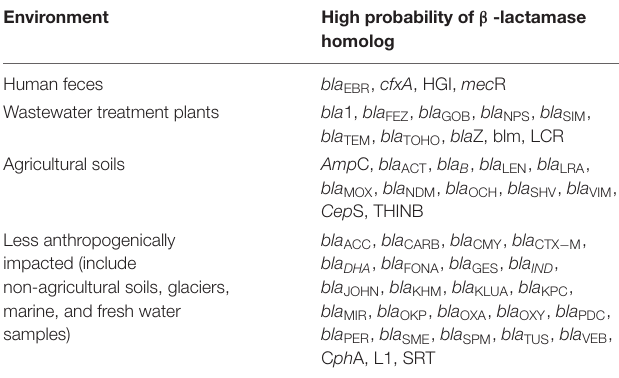
TABLE 1 | Faithfulness of β -lactamase homolog occurrence based on indicator species analysis in selected metagenomes with varying levels of anthropogenic